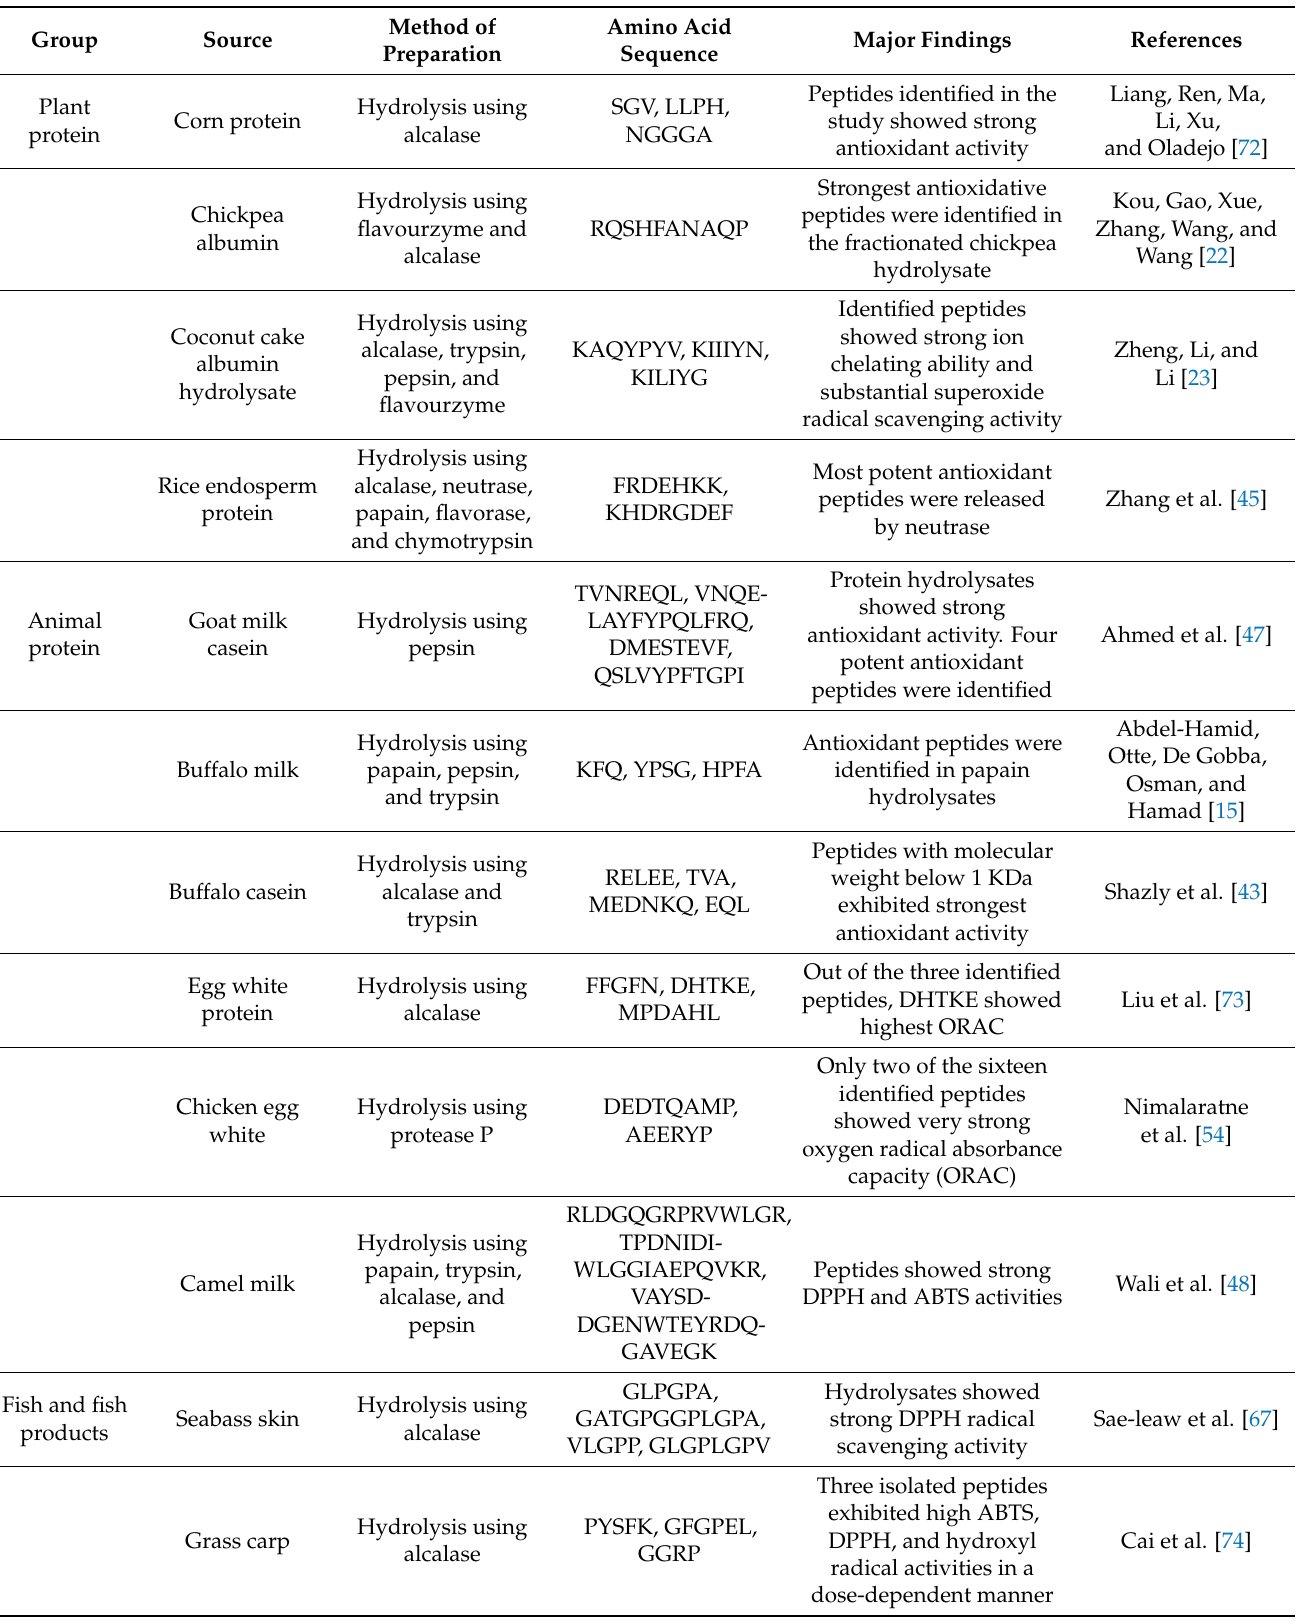
Table 2. Antioxidant peptides from food